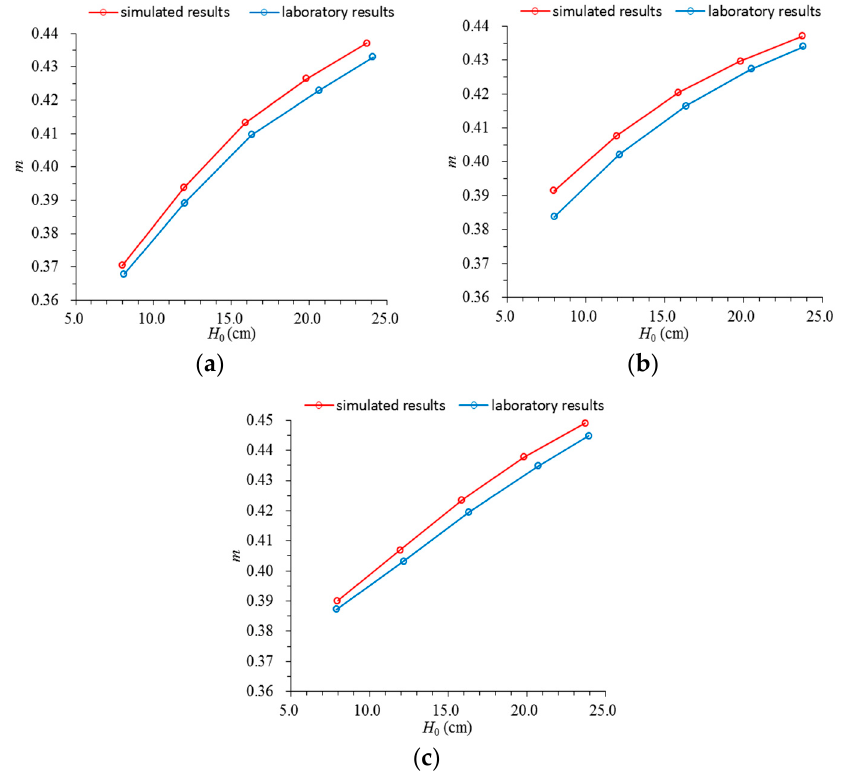
Figure 3. Comparison of discharge coefficients between numerical results and laboratory results for: